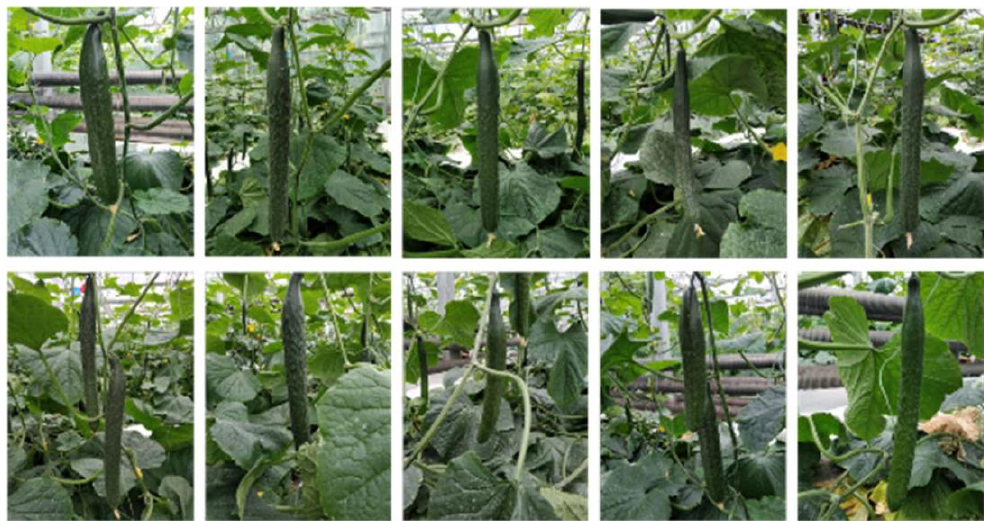
Figure 6. Samples of cucumbers in a natural complex environment (Photo: Reprinted with permission from Ref. [136]. 2020, Mao S.).